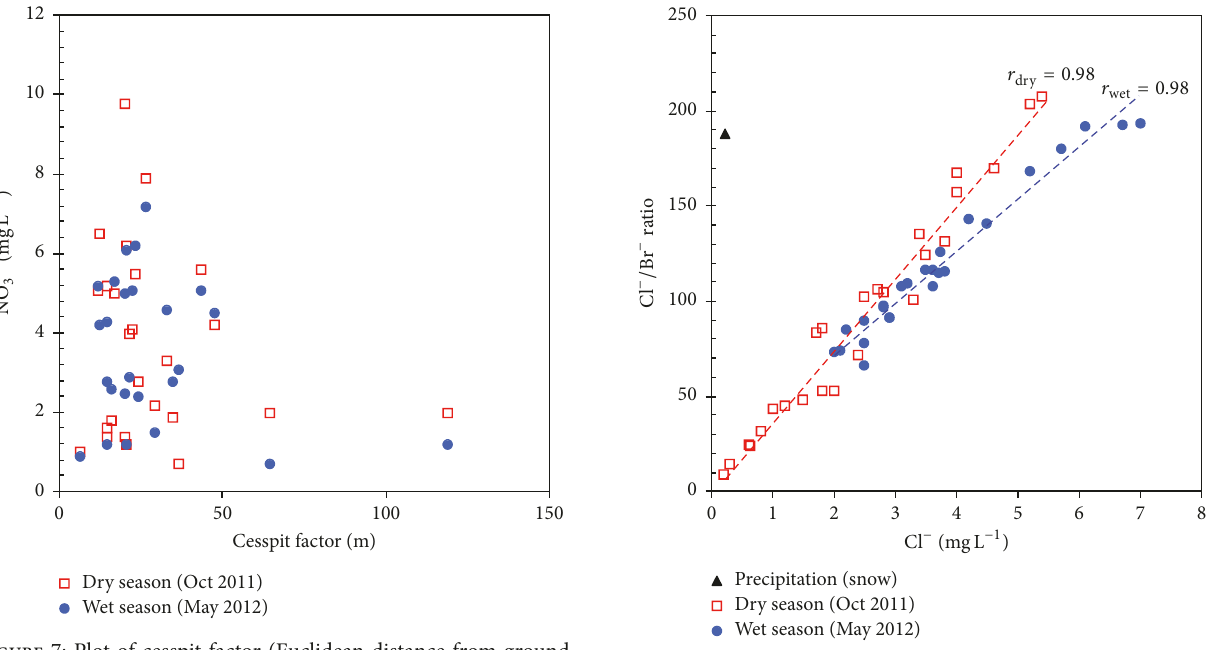
Figure 8: Plot of Cl − concentration versus Cl − /Br − ratio for dry and wet season groundwater samples. Precipitation data reflects the average of 11 snow samples collected from the site on January 2012 ( 𝑛 = 6 ) and February 2013 ( 𝑛 = 5 ) after two major snowfall